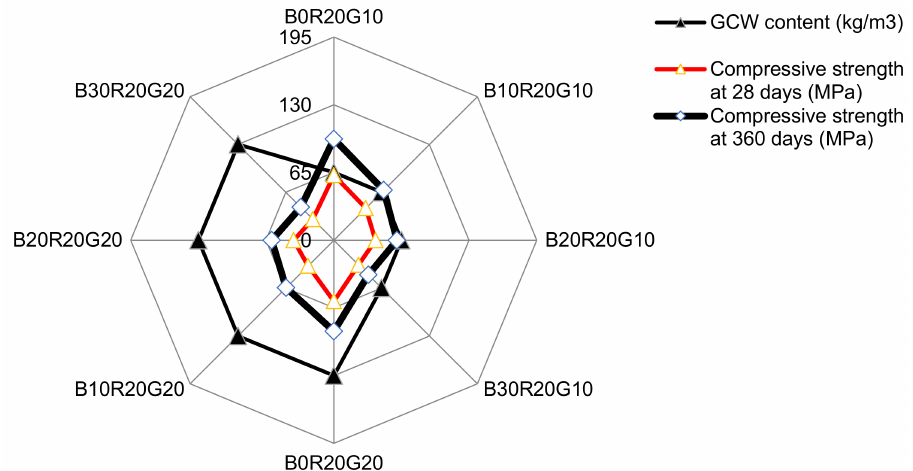
Figure 8. Relationships between compressive strengths of concretes and cement substitution levels of GCW in gSCC